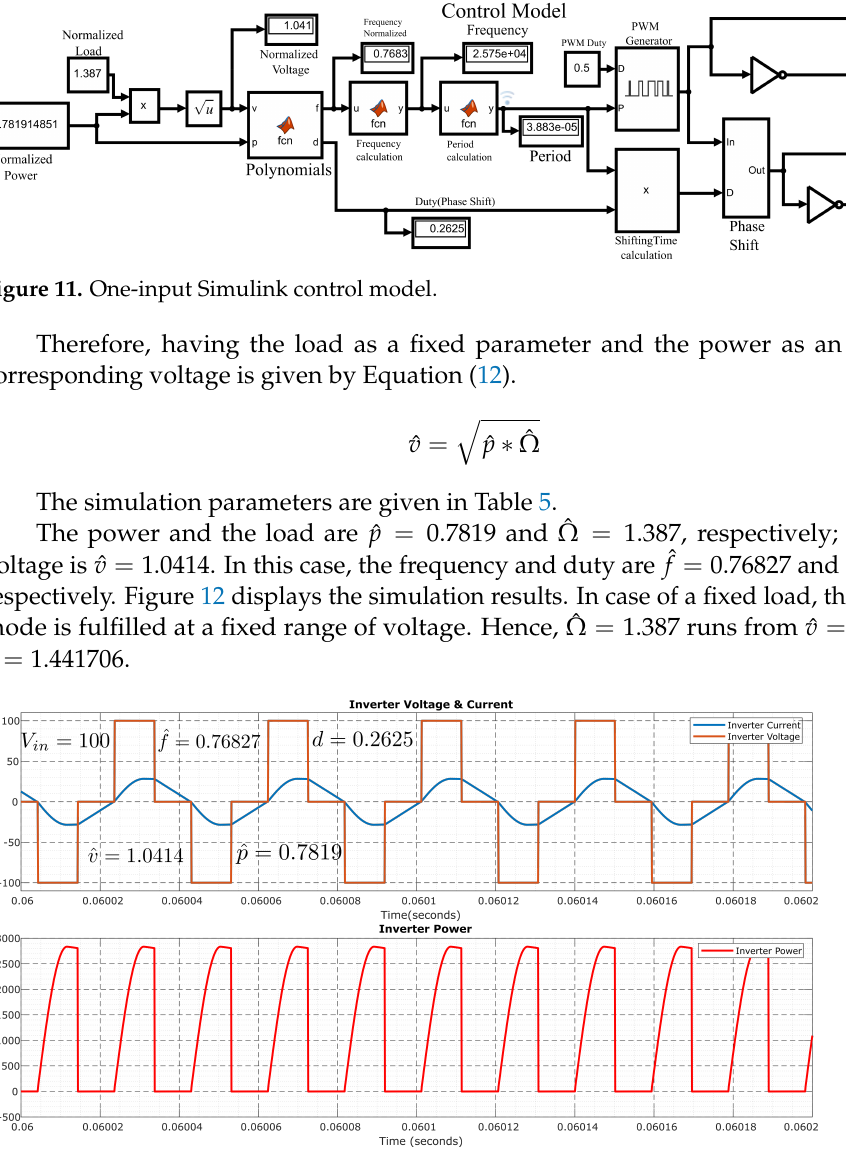
Figure 12. Inverter voltage, current, and power at fixed